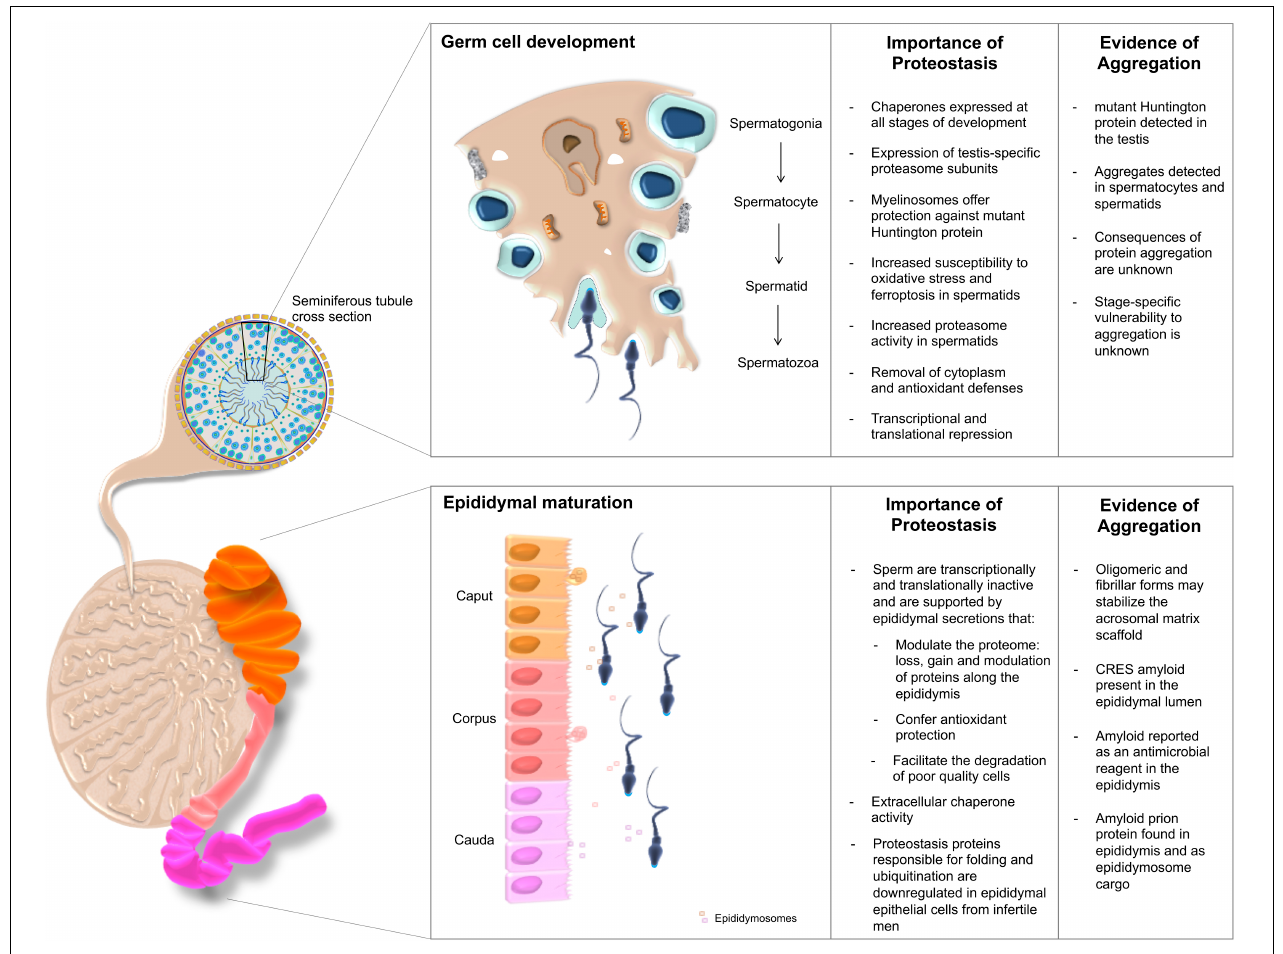
FIGURE 2 | The importance of proteostasis throughout male germ cell development. Male germ cells are produced through successive waves of spermatogenesis occurring within the seminiferous tubules of the testes, yet acquire functional competence during their subsequent transport through the epididymis. The integrity of both maturational phases is intimately regulated by complex proteostasis networks, which work in concert to secure the continuous production of high quality spermatozoa. Despite these quality control measures, the formation of protein aggregates has been documented at various sites within the male reproductive tract. Although their origins remain largely enigmatic, such deposits have been ascribed both pathological and functional